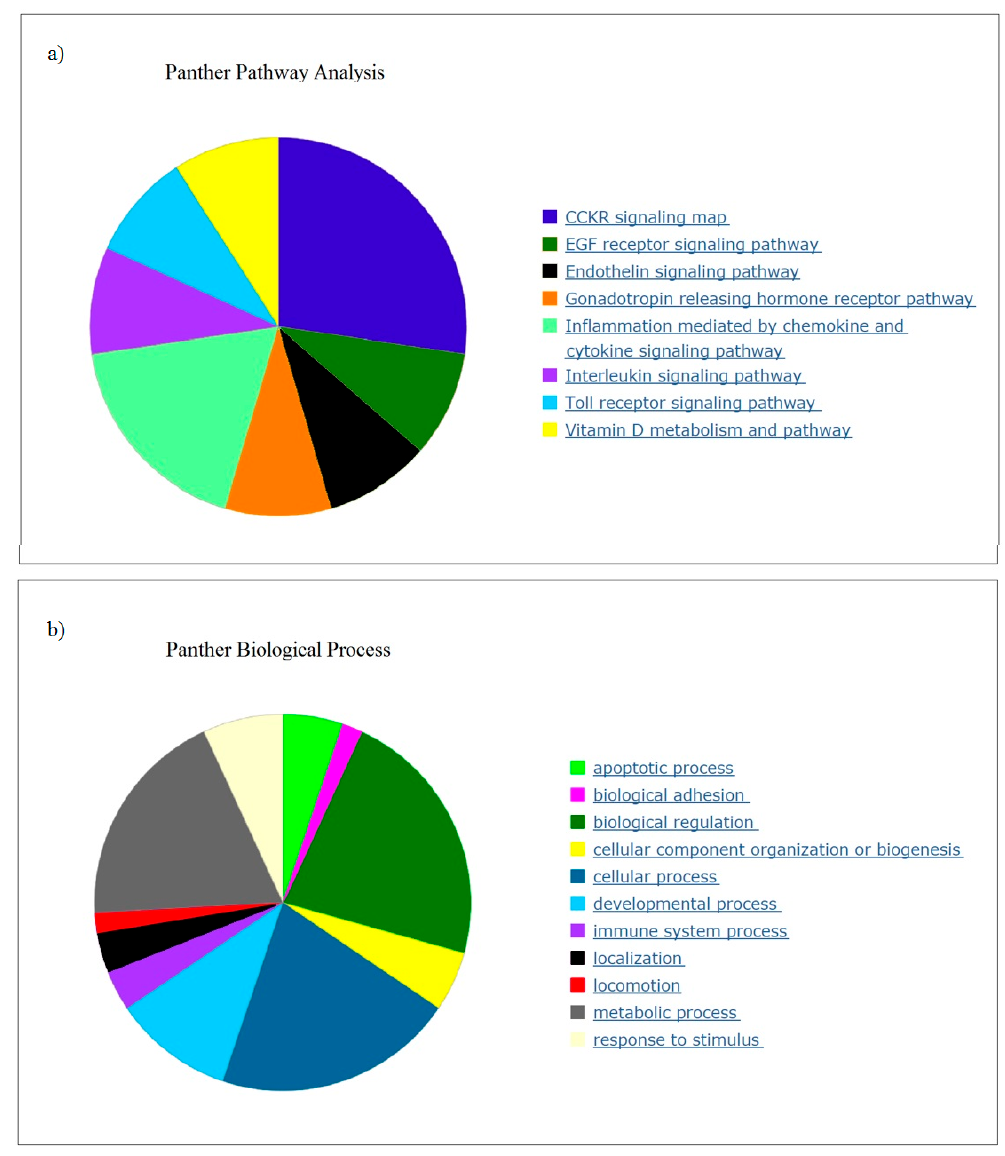
Figure 1. Gene classification pie charts created in PANTHER (Protein ANalysis THrough Evolutionary Relationships). ( a ) pathways; and ( b ) biological process associated with the >1.4-fold change (FC) gene expression change in response to olive leaf extract (OLE) consumption. The key names the pathways (starting from the top and moving clockwise) that have been regulated with OLE relative to placebo (PBO)